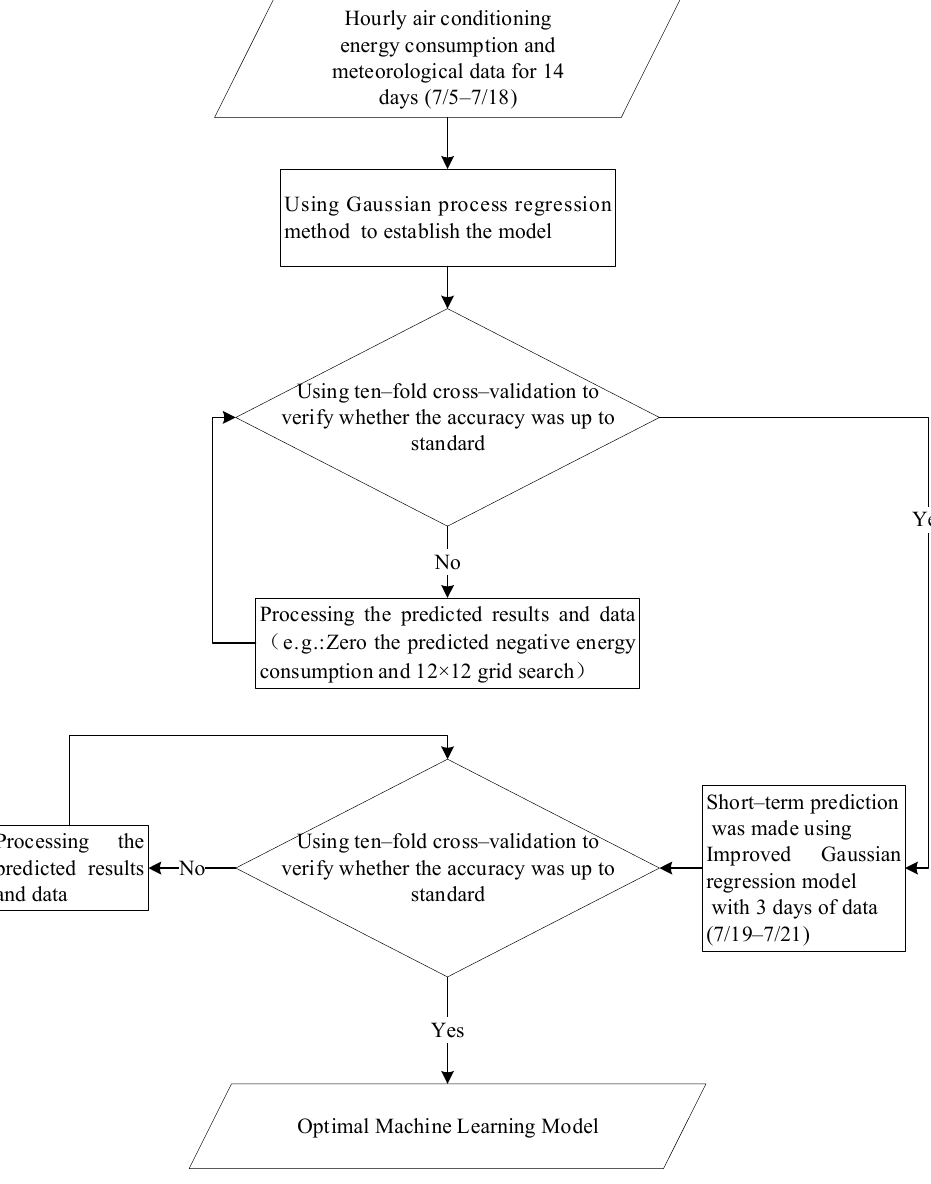
Figure 4. Modeling flow chart .